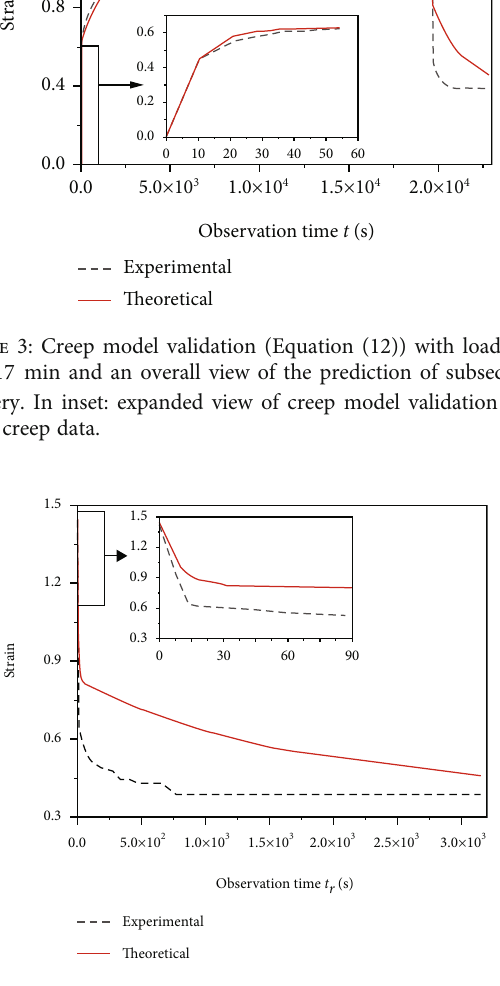
Figure 4: Expanded view of the prediction of the whole recovery curve with the parameters evaluated from the creep curve in Figure 3. In inset: expanded view of the prediction of initial recovery